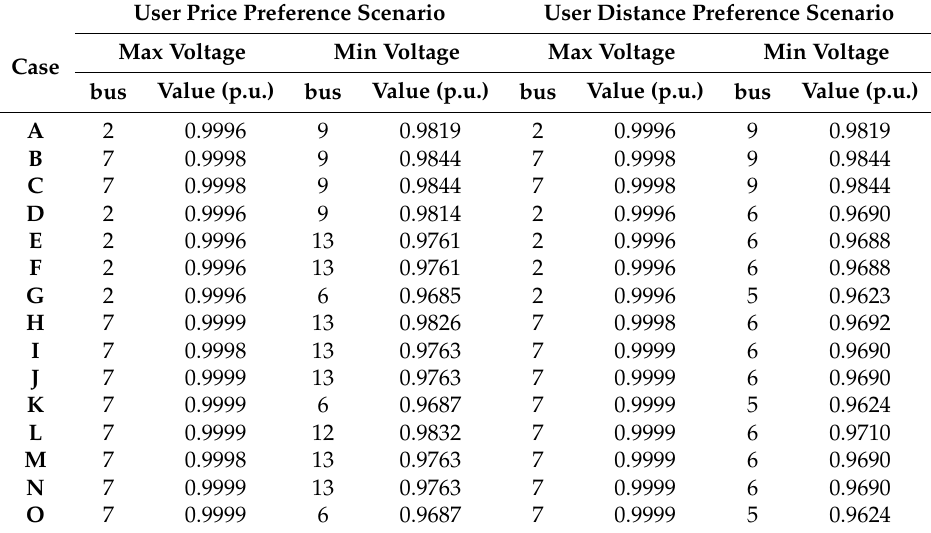
Table 10. Maximum and minimum voltage magnitude for each case